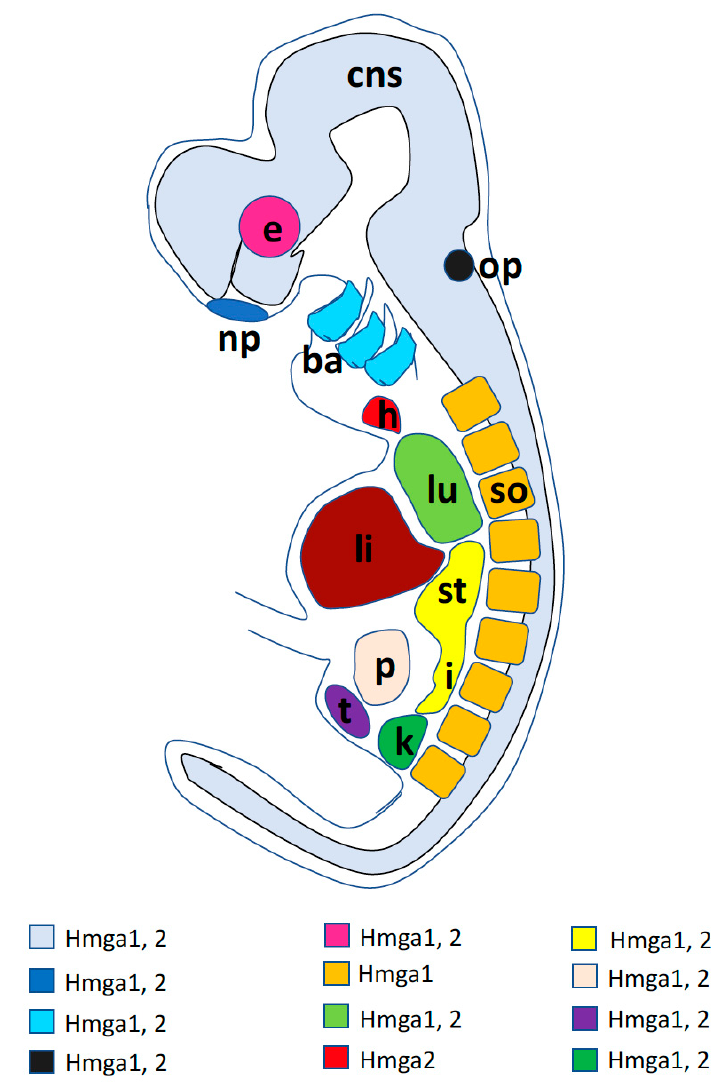
Figure 2. Graphic summary of the main sites of expression of Hmga1 and Hmga2 genes in a generalized vertebrate embryo. Colored codes resume the expression of the two genes as described in the text: ba, branchial arches; cns, central nervous system; e, eye; h, heart; i, intestine; k, kidney; li, liver; lu, lung; np, nasal placode; op, otic placode; p, pancreas; so, somites; st, stomach; t, testis.